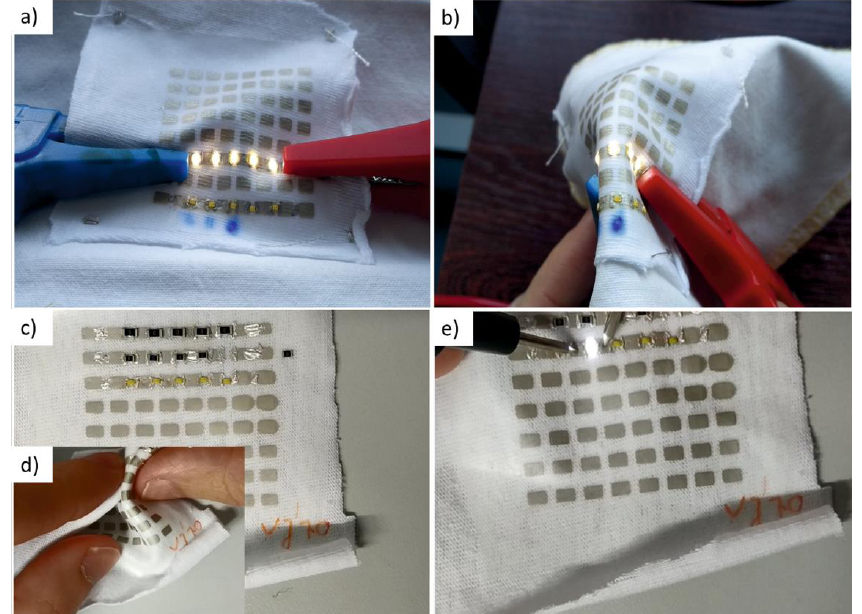
Figure 7. Optical images of textile with die-attached LEDs and resistors before bending ( a ), during bending ( b ), before crease ( c ), during crease ( d ) and after crease relief ( e ).